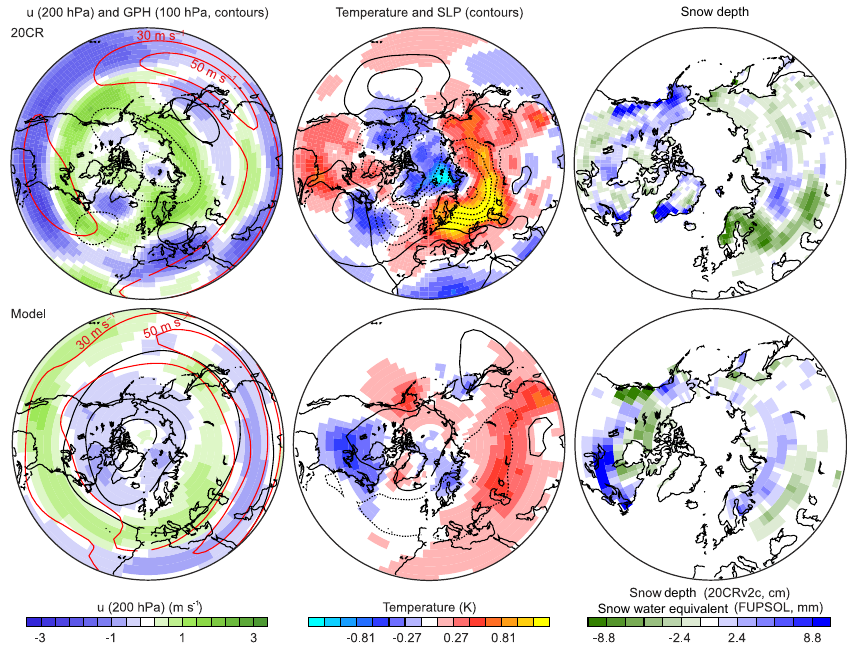
Figure 3. Composite fields for easterly minus westerly QBO phases for (left) 200hPa zonal wind (shading, red contours indicate climatology) and 100hPa GPH (black contours, spacing 24gpm, symmetric around zero, dashed are negative), (middle) surface air temperature (shading) and SLP (contours, spacing 0.6hPa, symmetric around zero, dashed are negative), all January–March and (right) March snow cover. See Fig. S5 for